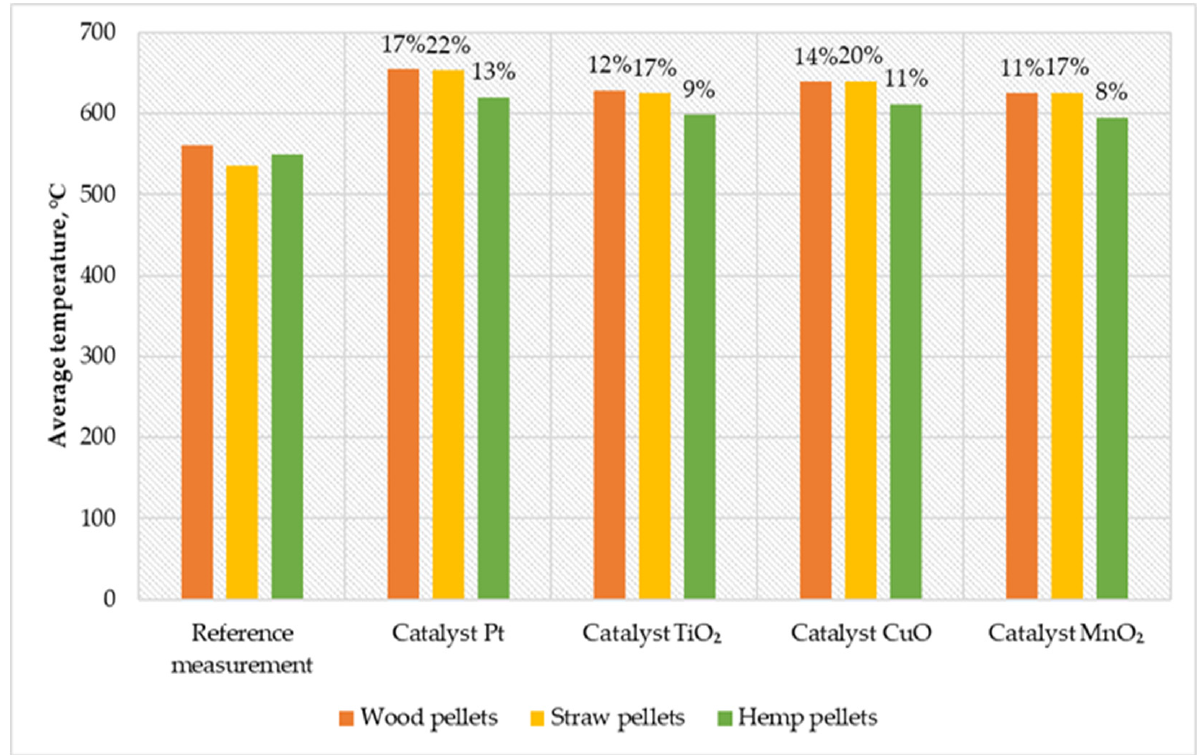
Figure 4. Comparison of average temperatures in the combustion chamber of a low-power biomass boiler.